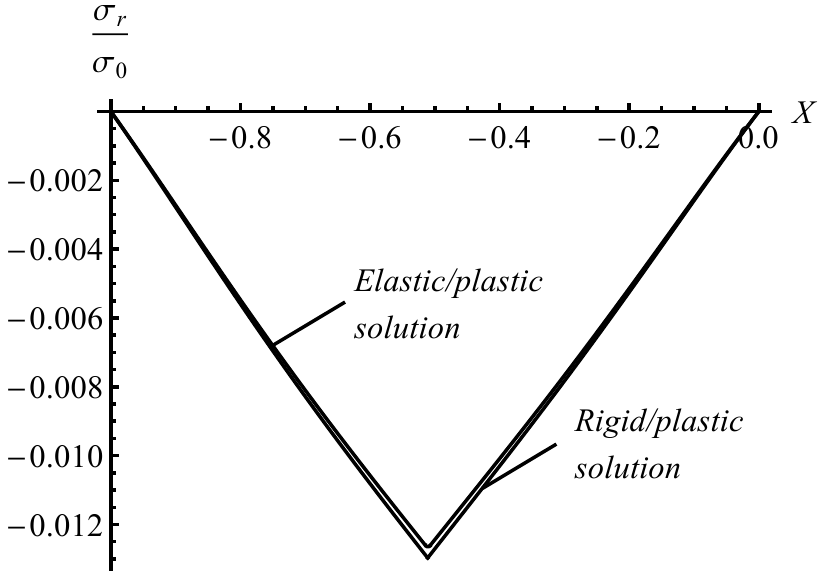
Figure 4. Distribution of the stress σ r at H / r CD = 0.04 found using the elastic/plastic and rigid/plastic solutions.